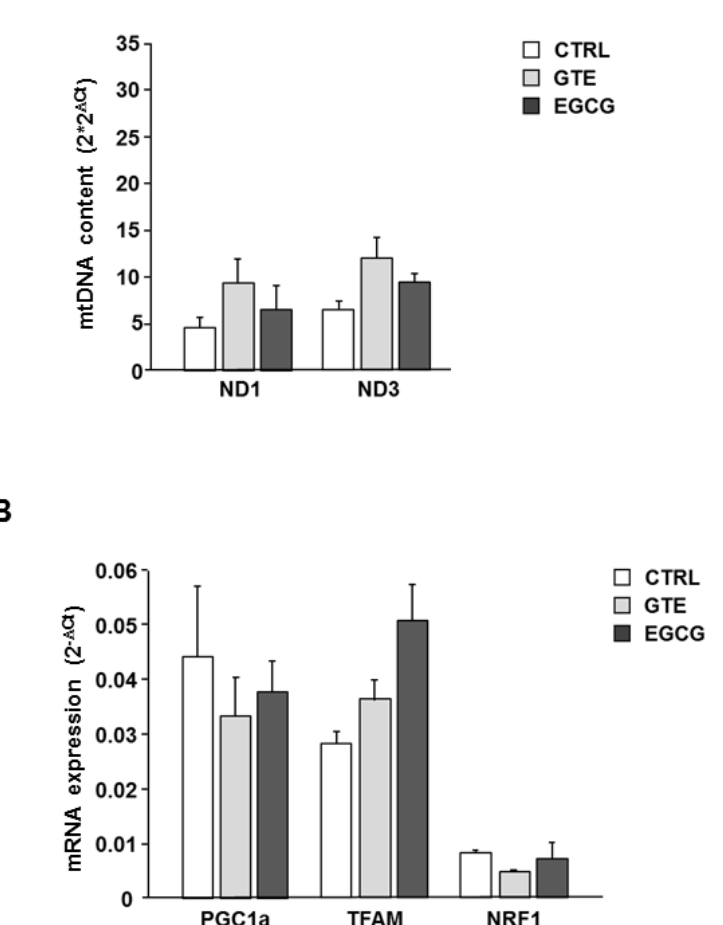
Figure 4. Effects of GTE and EGCG on LV heart tissue mtDNA content and mitochondrial biogenesis. ( A ) Relative mtDNA content measured in LV heart tissue of CTRL ( n = 2), GTE- ( n = 3), and EGCG-supplemented rats ( n = 3). ND1 , ND3 region of the mtDNA were amplified. Data were normalized to the content of nuclear DNA, estimated by GAPDH amplification. On the Y axis 2 × 2 ∆ Ct ± SEM has been reported, where ∆ Ct = Ct − Ct nucl gene mito gene. ( B ) Relative expression of genes involved in mitochondrial biogenesis measured in LV heart tissue of CTRL ( n = 2), GTE- ( n = 3), and EGCG-supplemented rats ( n = 3). On the Y axis 2 − ∆ Ct ± SEM has been reported, where ∆ Ct = Ct target gene − Ct GAPDH